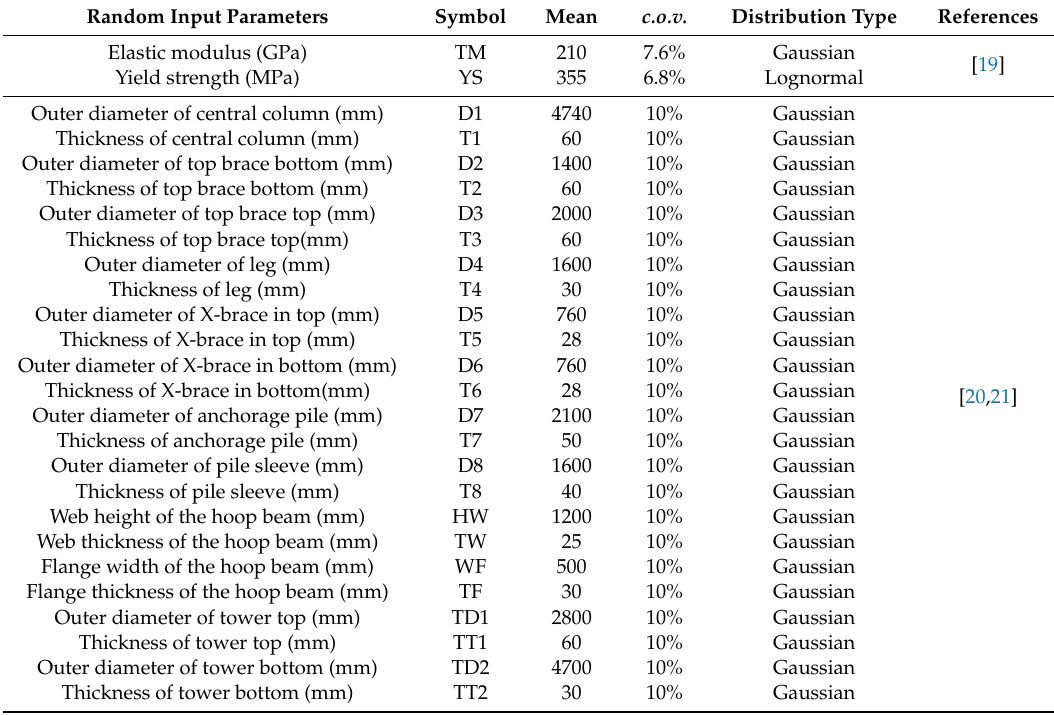
Table 1. Random input parameters